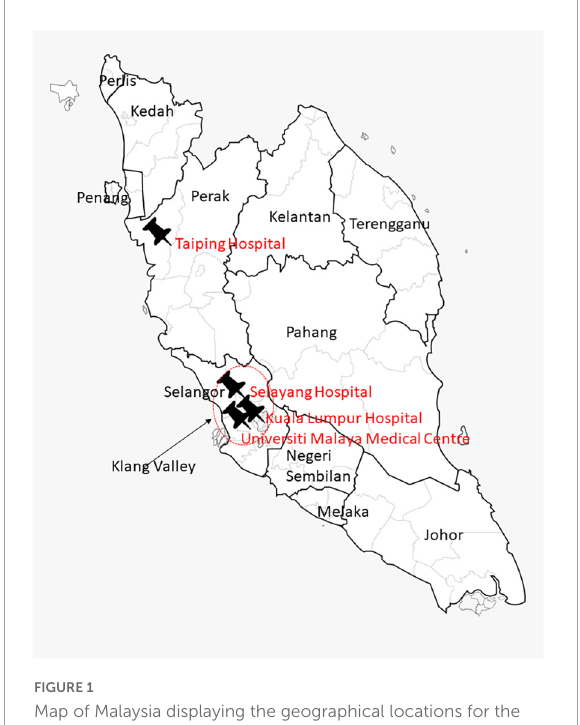
FIGURE1 Map of Malaysia displaying the geographical locations for the four study sites. The red circle identifies the Klang Valley, the location of three of the four study sites: Universiti Malaya Medical Centre, Kuala Lumpur Hospital, and Selayang Hospital. Taiping Hospital is located in the northern state of